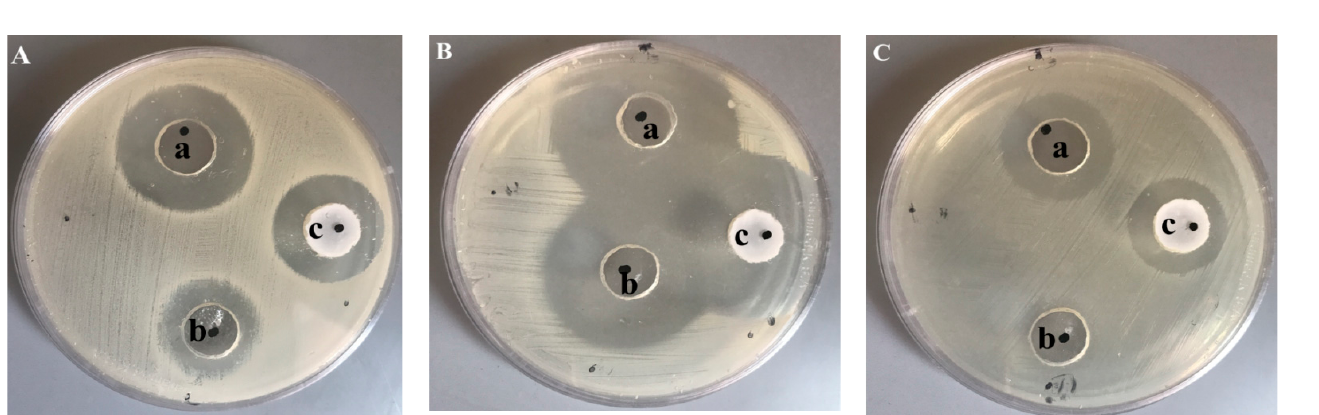
Figure 7. Inhibition zone caused by examined formulations: (a) FA-SLN-hydrogel, (b) placebo SLN-gel and (c) marketed FA (Fucidin ® ) on different bacterial strains: ( A ) Bacillus subtilis , ( B ) Staphylococcus aureus and ( C ) Klebsiella pneumonia .